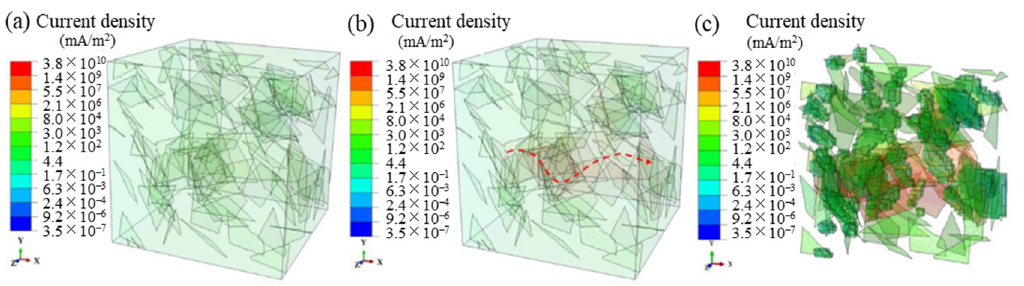
Figure 2. ( a ) SEM image of possible tunneling effect between CNTs in nanocomposites; ( b ) tunnel resistance modeling of resistance network [35] (Copyright 2008, Elsevier Ltd.).